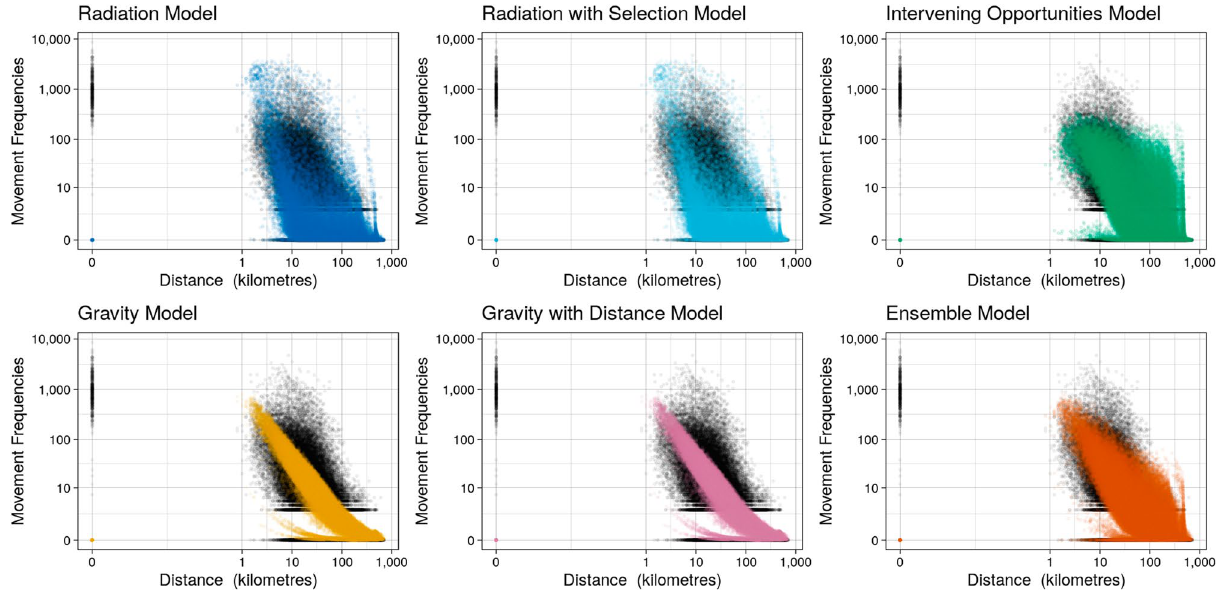
Figure 1. Comparison of predicted frequency of movements by distance (kilometres) between pairs of locations for each model type, based on journey to work Census data. Black points show the raw movement frequencies that were used to train each model. Coloured points show the resulting model predictions. Movement frequency and distance are shown on a log-scale to better highlight differences between model predictions. This figure was produced using the R 33 package ggplot2 34